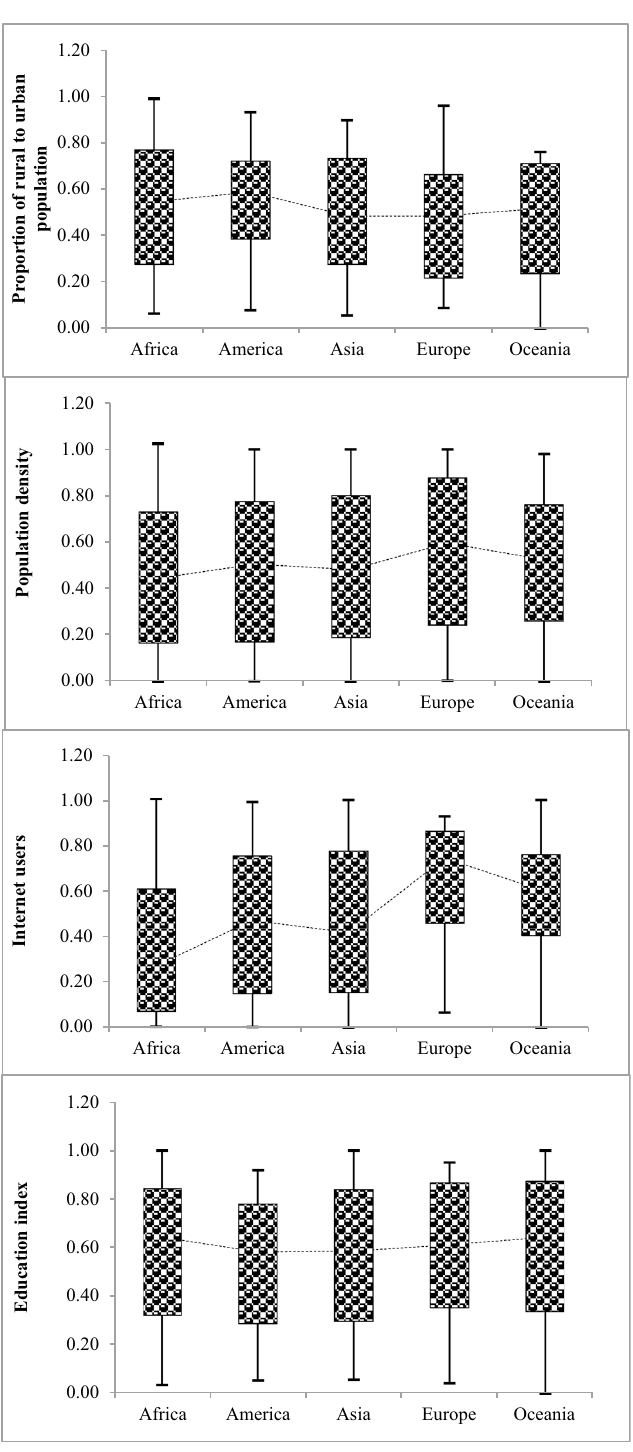
Figure 12. Distribution of estimated data values of social indicators ( P i , i = 1, 2, …, 4).